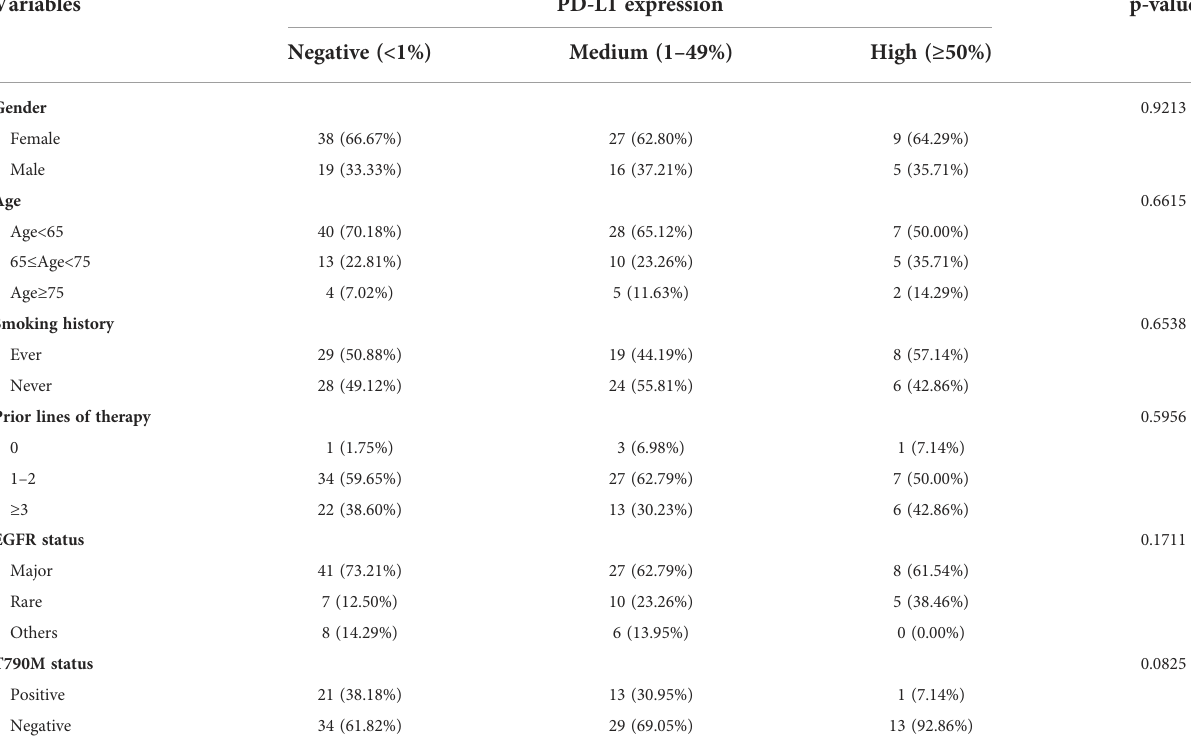
TABLE 2 Risk factors analysis of PD-L1 expression in EGFR-mutated